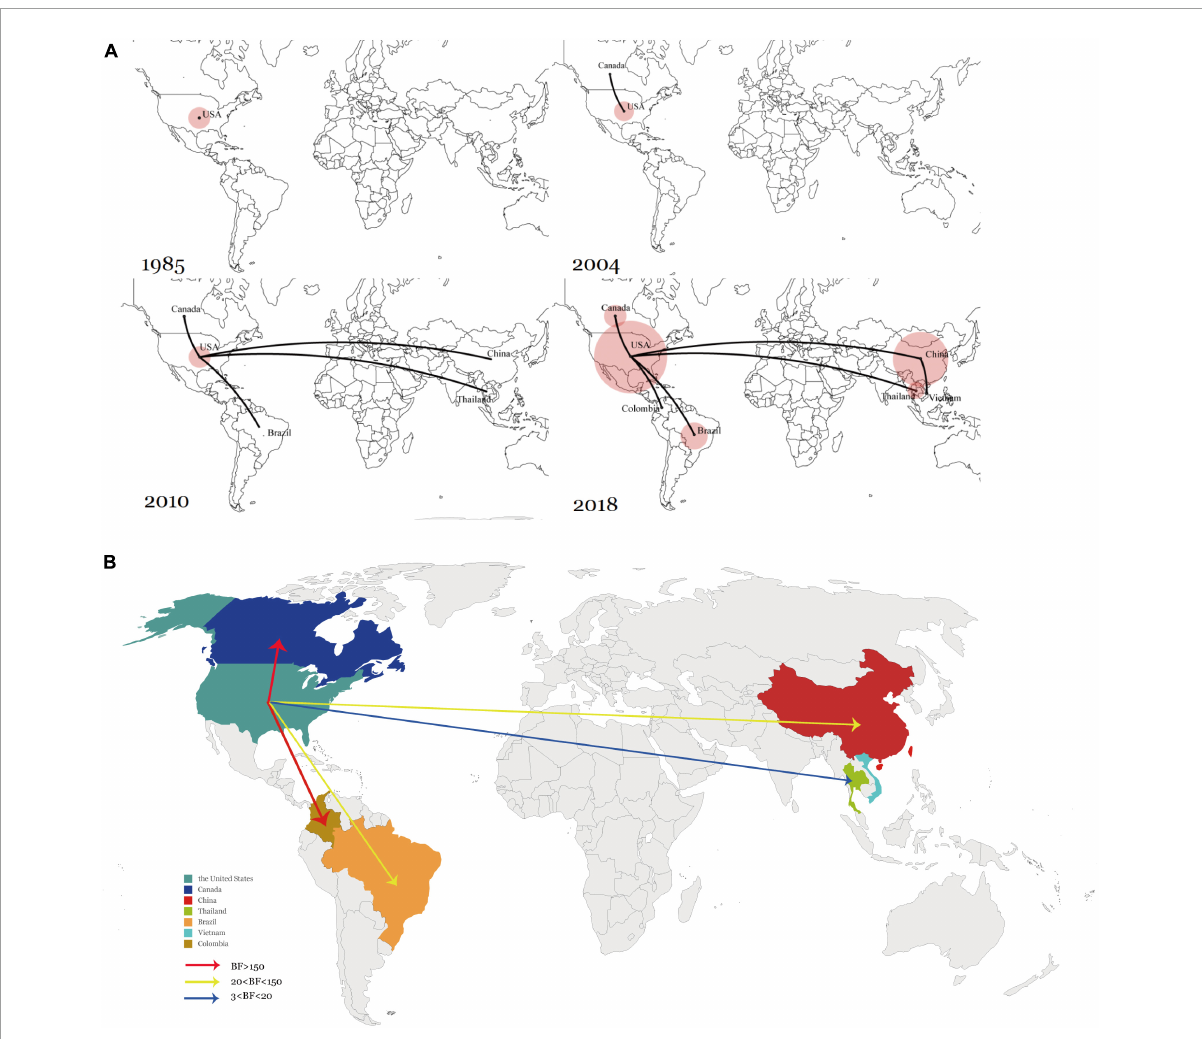
FIGURE4 (A) Spatiotemporal dynamics of SVA among different regions. (B) Global transmission links of SVA tested by Bayes Factor for significant non-zero rates supported by the BSSVS. Line colors represent the relative strength by which the rates are supported: very strong (BF > 150, red) and strong (20 < BF < 150, yellow), and positive (BF > 3). Line directions indicate the direction of